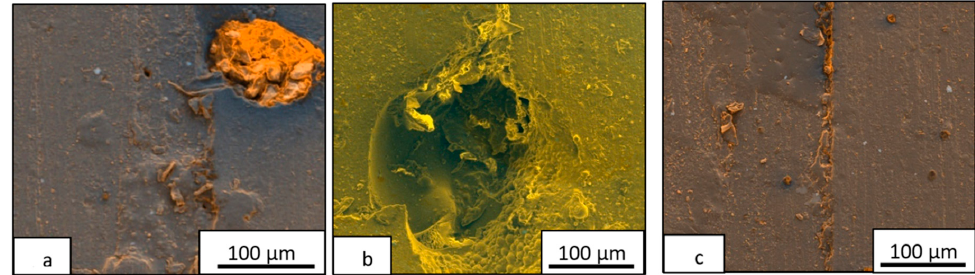
Figure 8. FEG-SEM images to analyze the self-healing mechanism of PCL/DGEBA/TETA blends with 10% ( a ), 25% ( b ), and 15% PCL ( c ).